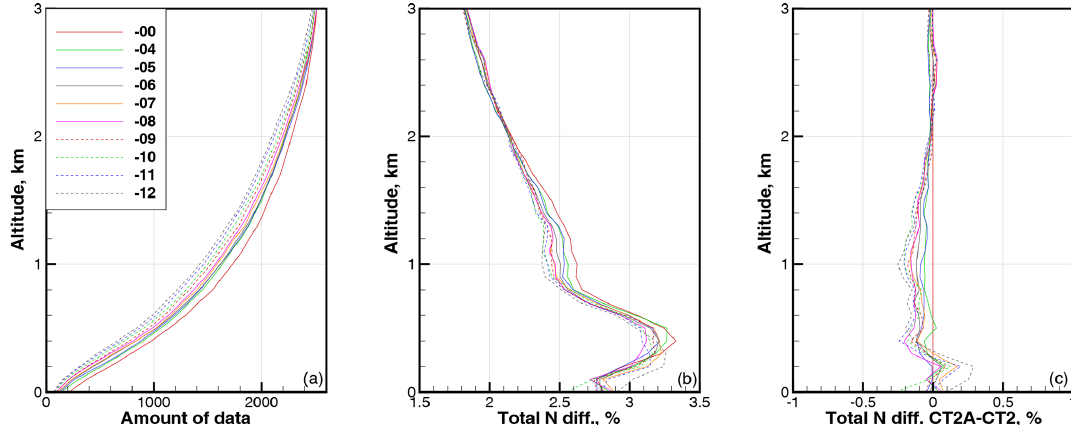
Figure 3. Statistics for latitude band 0–10 ◦ . (a) Amount of data. (b) RMS relative difference in refractivity COSMIC–ECMWF (cid:49)N CE . (c) RMS relative difference in refractivity CT2A–CT2. All are functions of the parameter β .